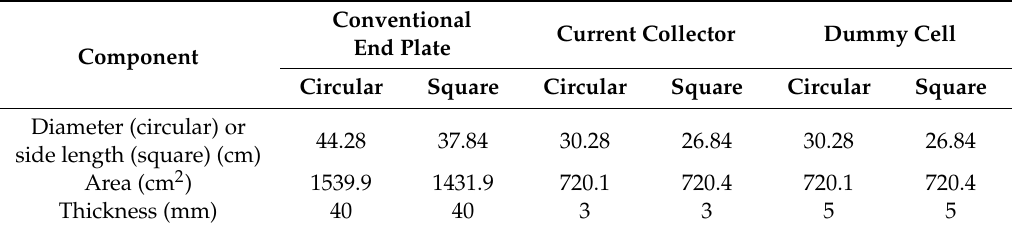
Table 2. Dimensions of the simplified PEMWE components. Conventional Current collector Component Circular Square Circular Square Circular